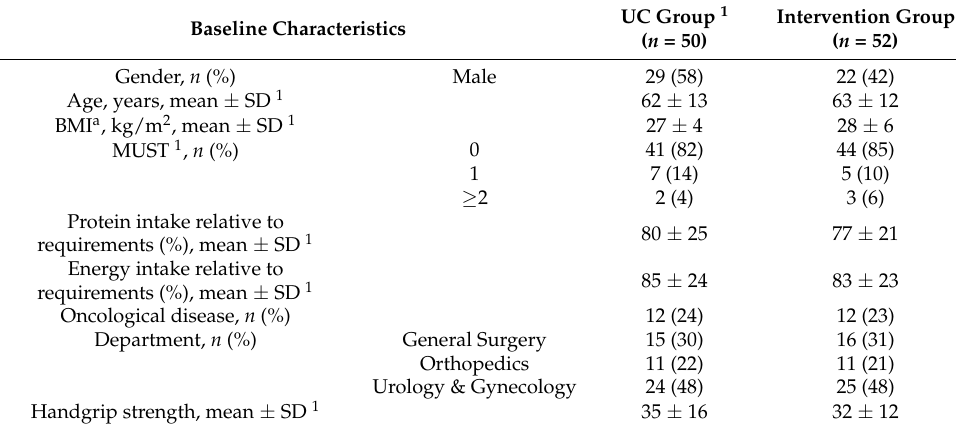
Table 1. Baseline characteristics of 102 surgical patients.